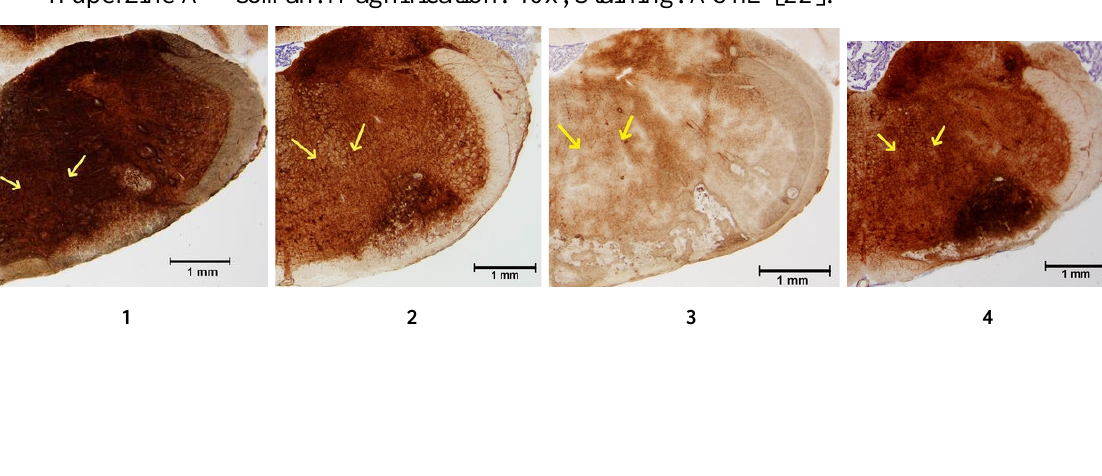
Figure 1. Top: Microphotography of 20 µ m sections of the rat brain (reticular formation, ncl. gigantocellularis, position is marked by arrow) following huperzine, soman